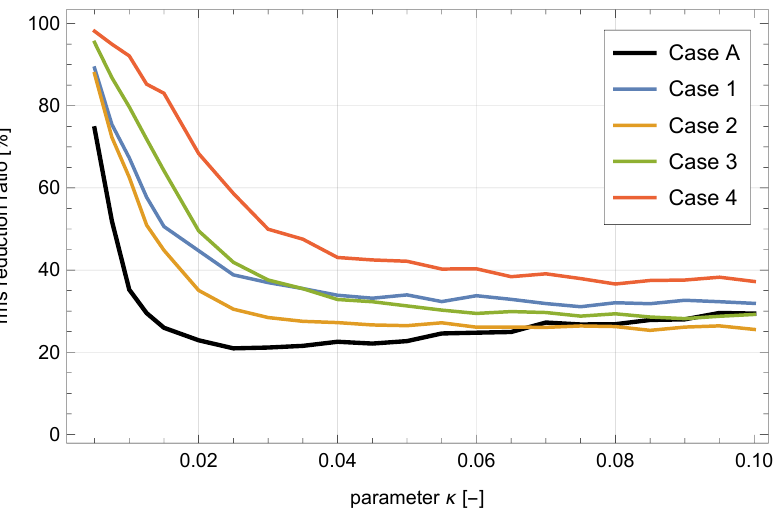
Figure 9. Dependence of the rms reduction ratio on the parameter κ for ∆ t = 5 ms in all control cases. Mean values were computed for 108 different random seismic